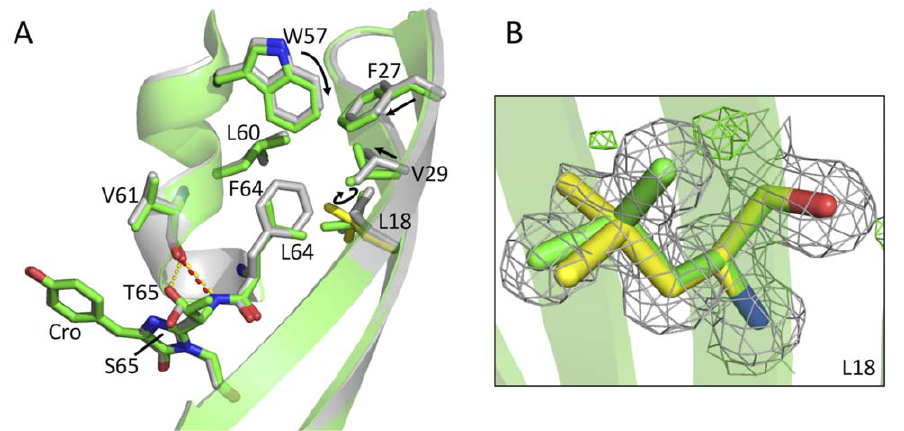
Figure 4. Effect of F64L mutation on EGFP structure. (A) Structural effects of the F64L mutation on the positions of L18, F27, V29, W57 and L64. EGFP and wt GFP coloured as in A. (B) 2F o -F c electron density map, contoured to 1 s , of the L18 double conformation. Each conformer is coloured green (fit to 70% occupancy) and yellow (fit to 30% occupancy).